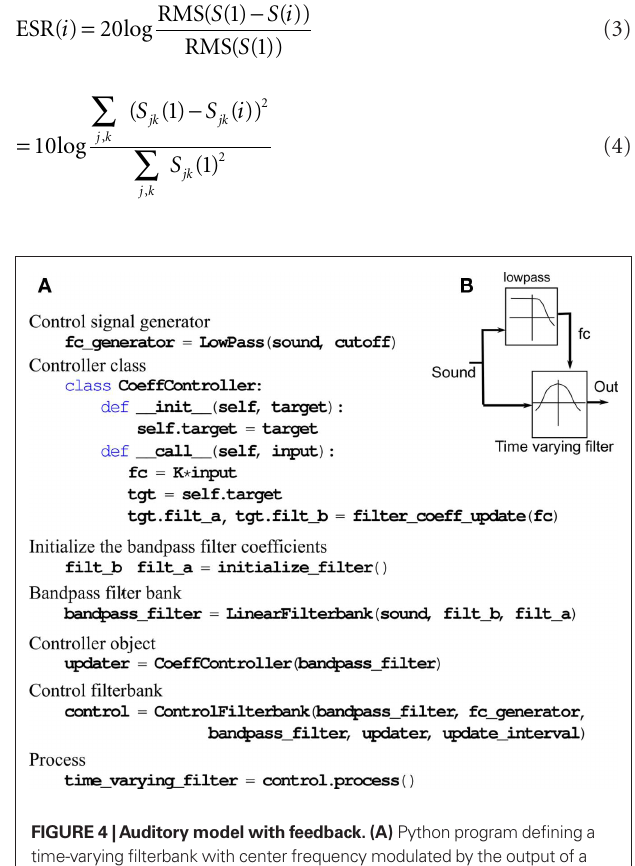
FiGUre 4 | Auditory model with feedback. (A) Python program defining a time-varying filterbank with center frequency modulated by the output of a low-pass filter using the Brian Hears toolbox. (B) Corresponding